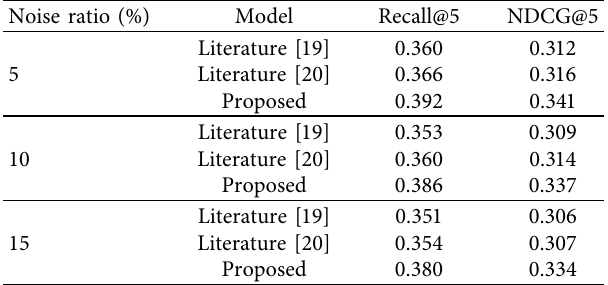
Table 2: Comparison of Recall@5 and NDCG@5 for different noise data.